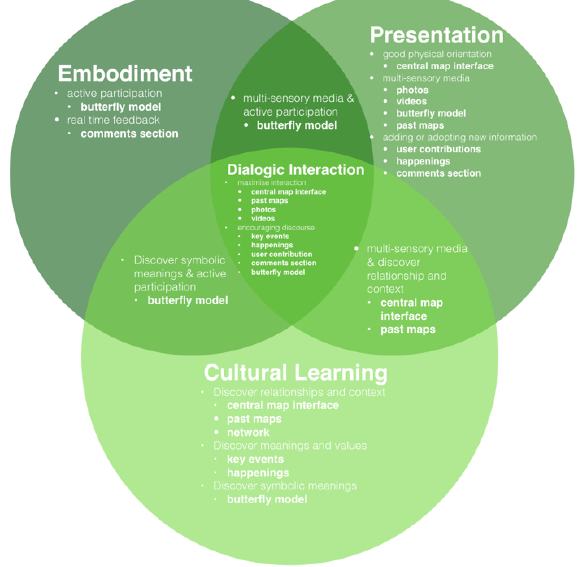
Figure 11. Classification of website features based on Rahaman (2012)